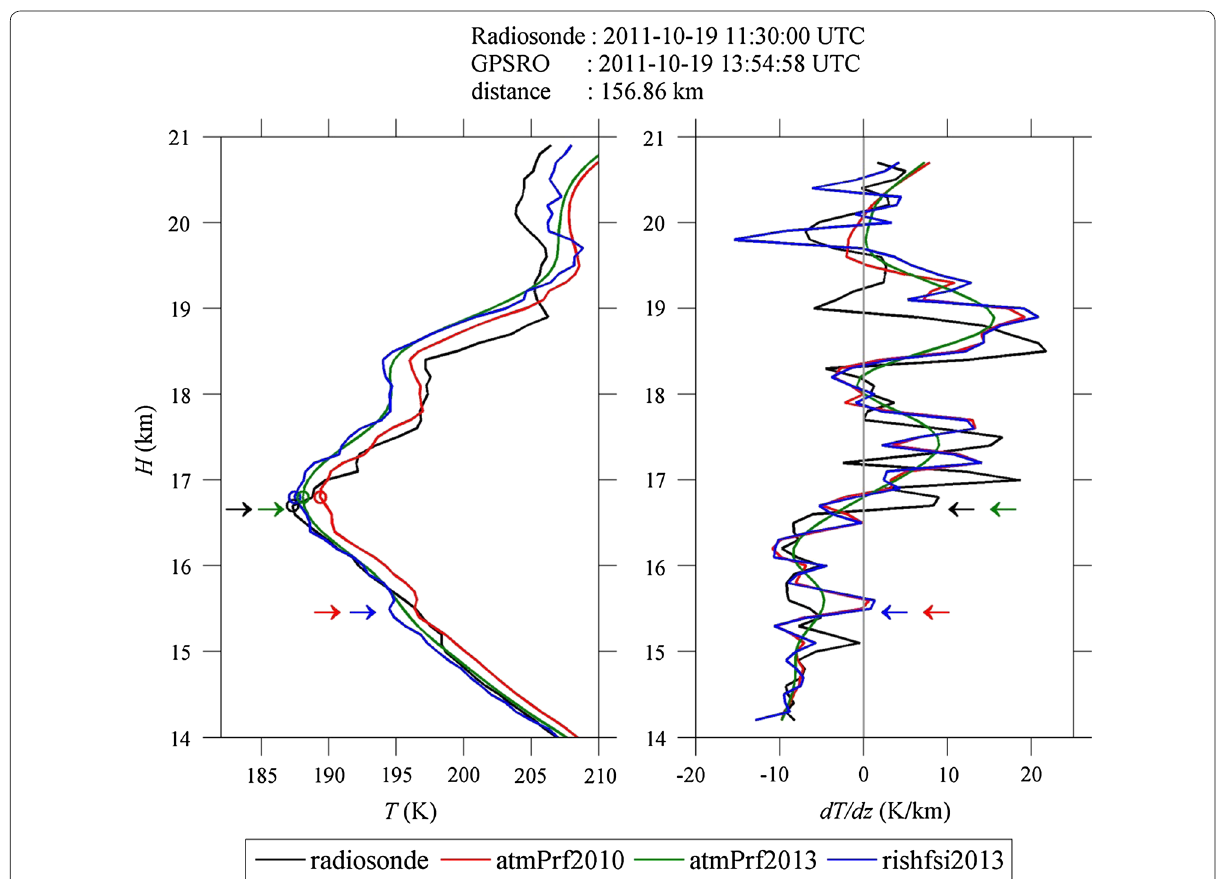
Fig. 12 Comparison of T and d T /d z between three GPS-RO profiles and a radiosonde. Black, red, green and blue lines show a radiosonde, atm- Prf2010, atmPrf2013 and rishfsi2013, respectively. Open circles in the right panel show CPT. Arrows in the right and left panels indicate